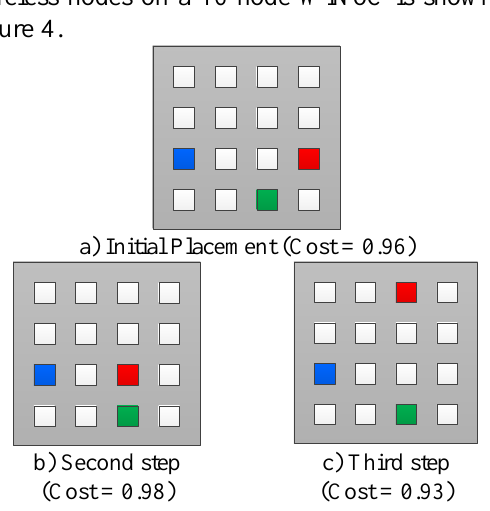
Figure 4. Three steps of algorithm 1 on a 16 node